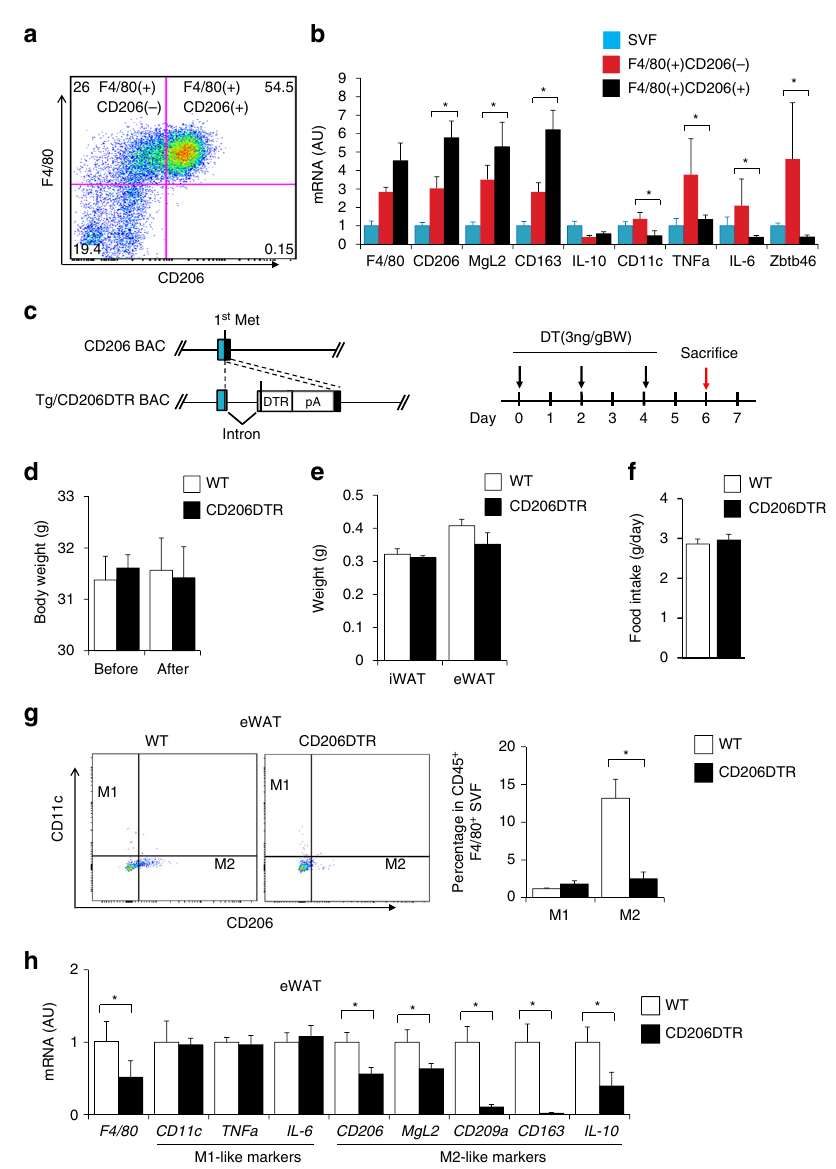
Fig. 1 Characterization of CD206 + ATMs. a Representative fl ow cytometry analysis of F4/80 and CD206 expression in the SVF of eWAT from WT mice ( n = 4 – 5). Full gating strategy is given in Supplementary Fig. 1. b Relative mRNA expression of SVF and FACS-sorted F4/80 + CD206 + from eWAT of WT mice. Sorted cell populations based on the expression of CD206 and F4/80 on the SVF CD45 + cells from eWAT of NC mice ( n = 4 – 5 mice per group). The data are shown as the means ± SEM. * P < 0.05 compared by ANOVA. c Schematic representation of CD206 and Tg/CD206DTR inserted transgene in BAC DNA (Tg, transgenic). Exons and the coding region of CD206 are indicated by open box and black boxes, respectively. Met is the initiation site of translation in CD206 and DTR. The inserted intron, DTR and polyA signals (pA) are indicated ( left panel ). A schematic diagram of the DT injection method for metabolic analysis of CD206DTR mice ( right panel ). d Body weights before and after DT injections, and e weight of adipose tissue and f food intake after DT injection period ( n = 4 – 6 mice per group). g Representative fl ow cytometry analysis of CD11c and CD206 expression in F4/80 + SVF cells of eWAT from WT and CD206DTR mice ( left panel ). Percentages of M1 and M2 macrophages were calculated ( right panel ) ( n = 5 – 6 mice per group). Full gating strategy is given in Supplementary Fig. 3. h The relative mRNA expression of M1/M2 macrophage markers in the eWAT after DT treatment ( n = 5 – 6 mice per group). The data are shown as the means ± SEM. * P < 0.05, ** P < 0.01 compared with littermates by Student ’ s t macrophages-reduced mice (Fig. 2f). Taken together, these data suggested CD206 + M2-like macrophages depletion triggered the − SVF. proliferation of CD45 macrophages in the control of APs proliferation. As shown in Fig. 3a, expression of a series of AP markers including PDGFRa, − 24 , and mesenchymal stem cell (MSC) CD24, Sca-1 , and Pref-1 21 CD206 + M2-like ATMs regulate adipocyte progenitor ’ s pro- markers including CD105 and CD90 25, 26 were up-regulated in liferation . We examined which type of CD45 − cells in the eWAT eWAT of the CD206 + M2-like macrophages-reduced mice. These were proliferating after CD206 + M2-like macrophages depletion. data indicated that proliferating cells might be APs. To directly − Sca-1 + assess the proliferation state of APs, the CD45 - CD31